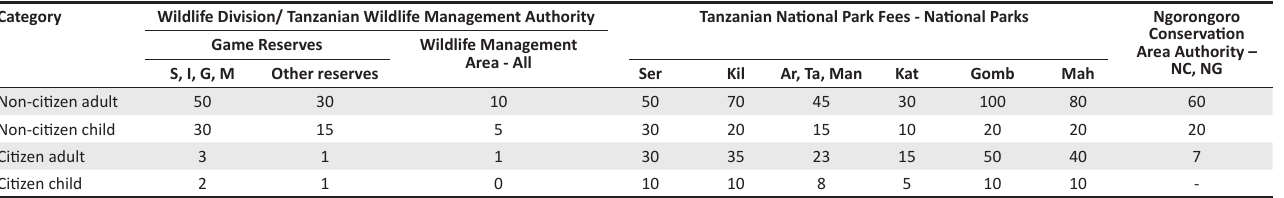
TABLE 1: Entrance fees charged by different protected areas in Tanzania (USD Equivalent). Category